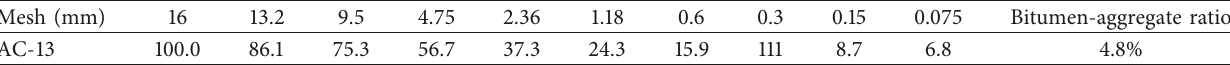
Table 1: Mixture gradations.